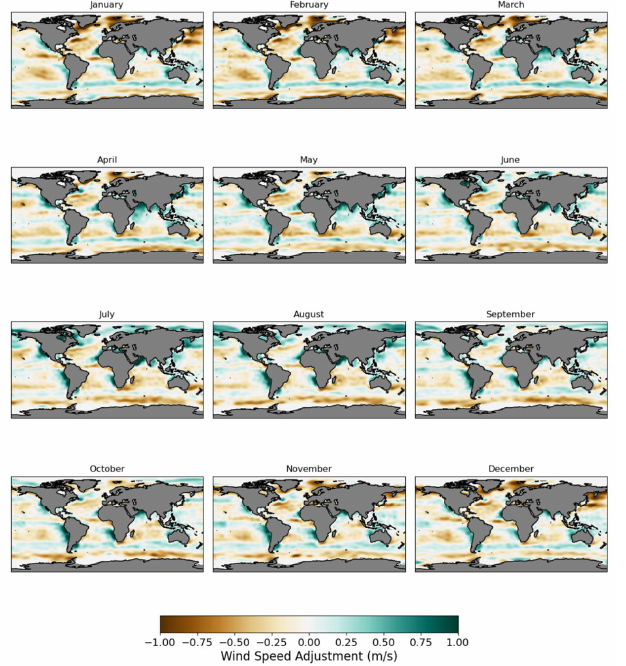
Figure A6. Wind Speed Adjustments applied to RAD_MED radiometer winds before inclusion in CCMP.